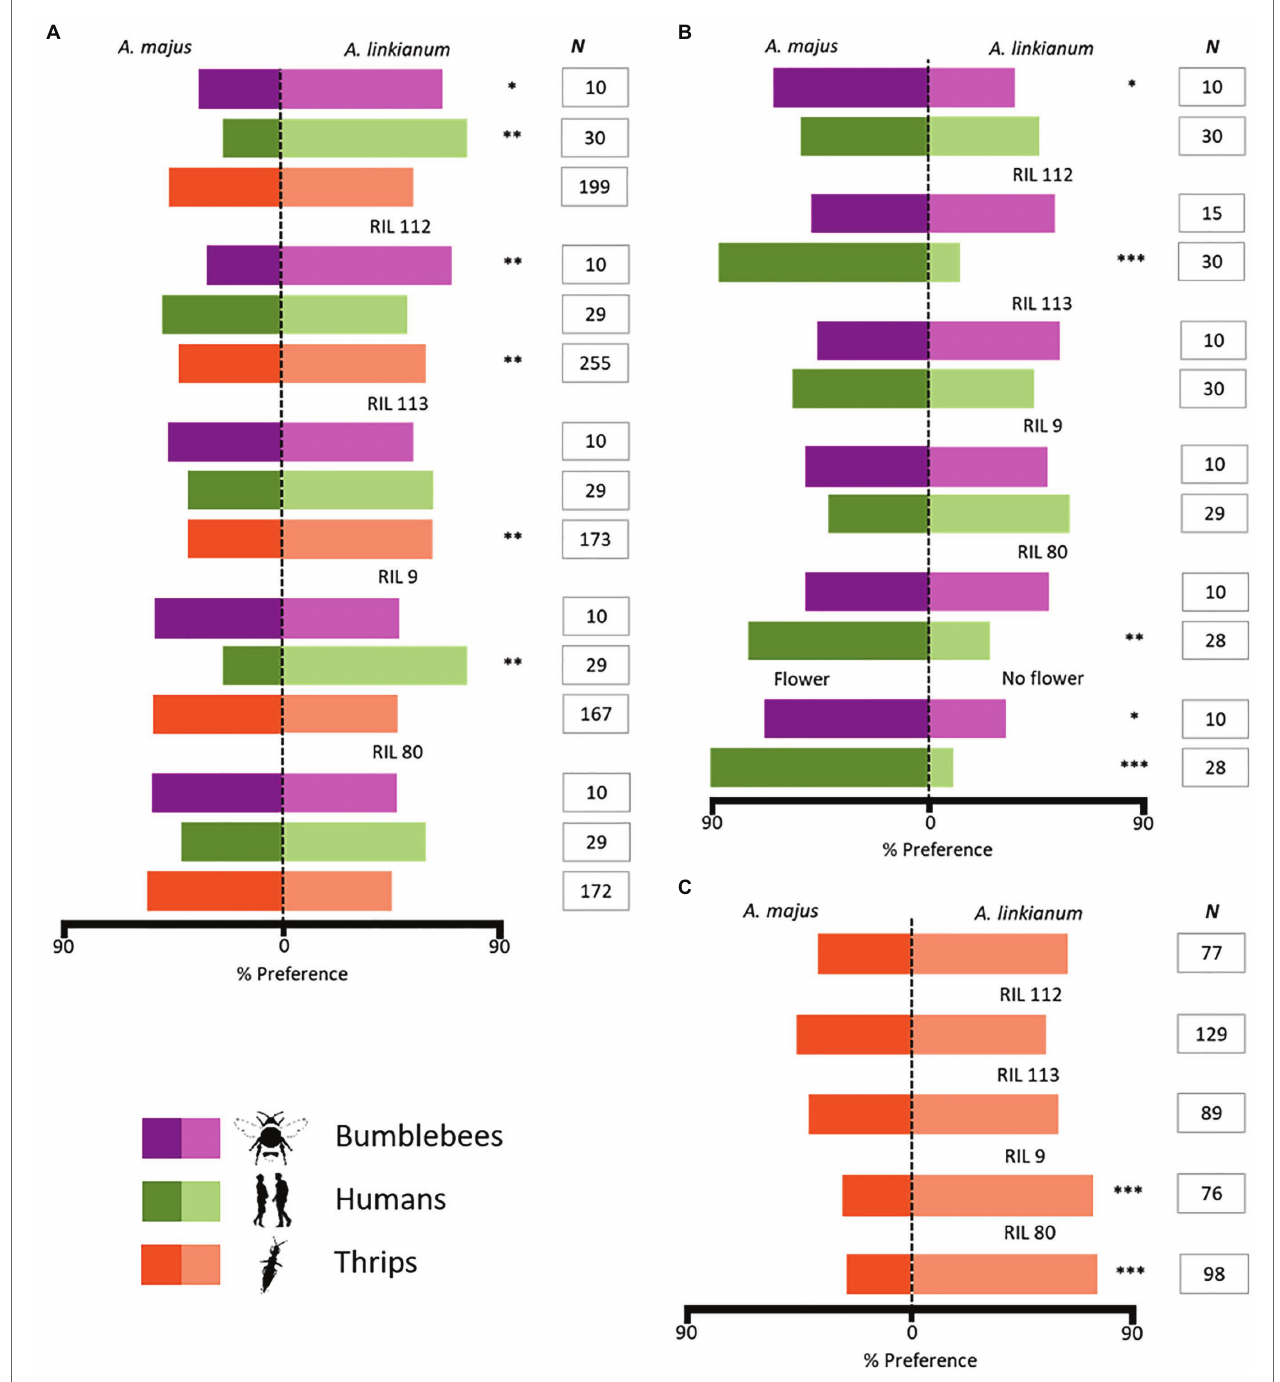
FIGURE 3 | Preference results of animals for flowers of Antirrhinum . (A) Preferences of bumblebees, humans, and thrips for whole flowers. (B) Preferences of bumblebees and humans for just the scent of flowers. (C) Preferences of thrips for stamens of flowers. All lines were compared with A. majus (except for the isolated scent from flower vs. no flower comparison in B ). Bumblebees (magenta), humans (green), and thrips (orange). Asterisks indicate the level of significance in statistical results: ( * ) p ≤ 0.05, ( ** ) p ≤ 0.01, and ( *** ) p ≤ 0.001. Non-significant results are not indicated. Number of replicates ( N ) per experiment is